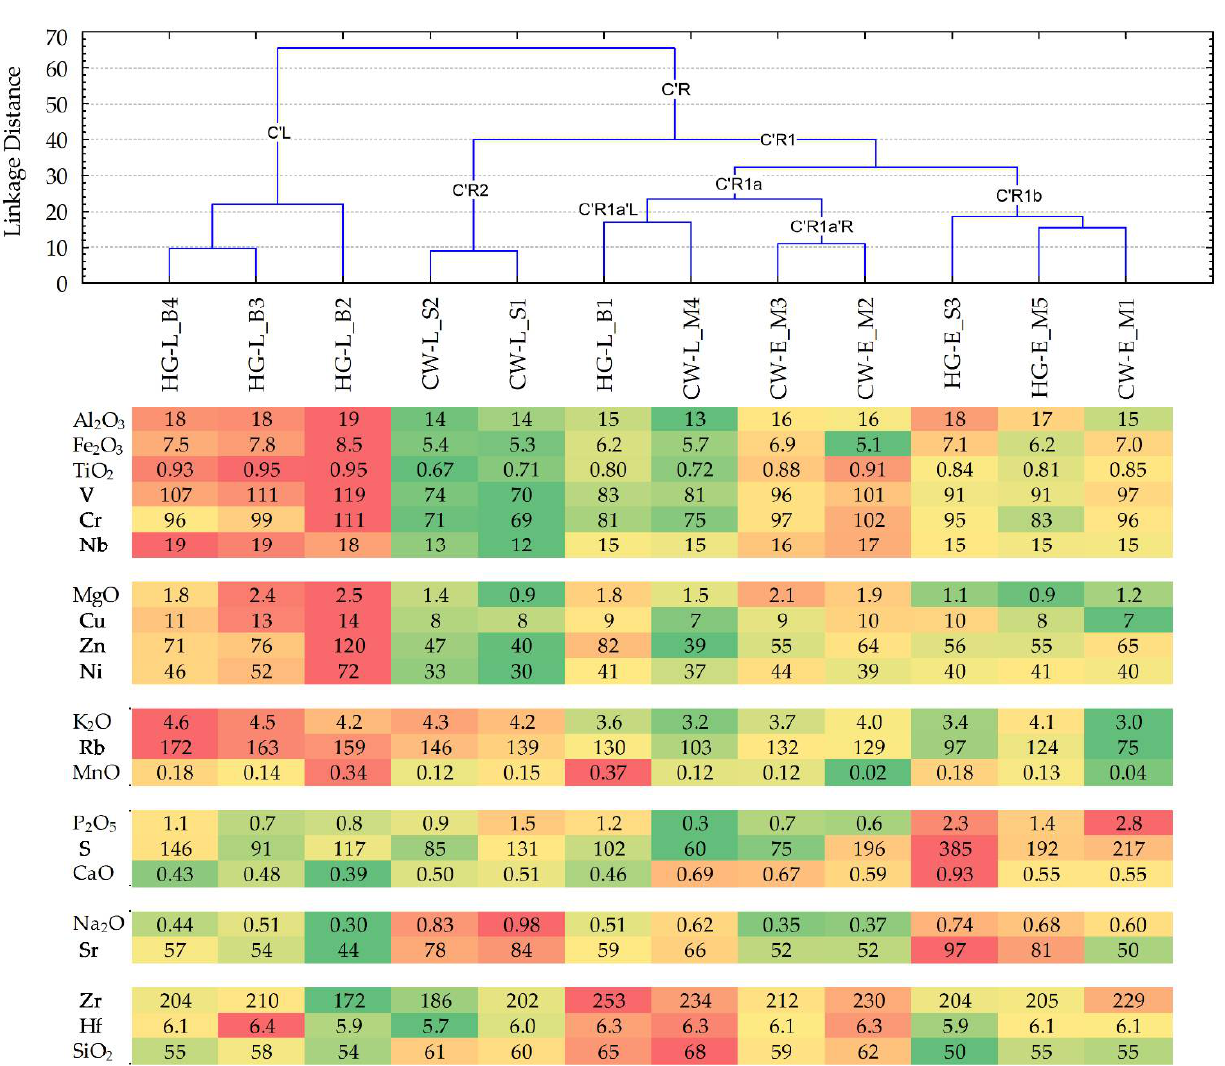
Figure 9. Dendrograms of the pottery samples (clustering using Ward’s method by calculating the Manhattan (City Block) linkage distances), compiled using the content of the major and trace elements in the bulk composition. At the bottom of the panel, using in conditionally formatted color scales, the individual elemental content is presented: %—for major analytes, recalculated by stoichiometry as oxides; µg g −1 —for trace elements. The sequences in the analyte groups correspond to the elemental cluster tree diagram for the Figure 3c panel.